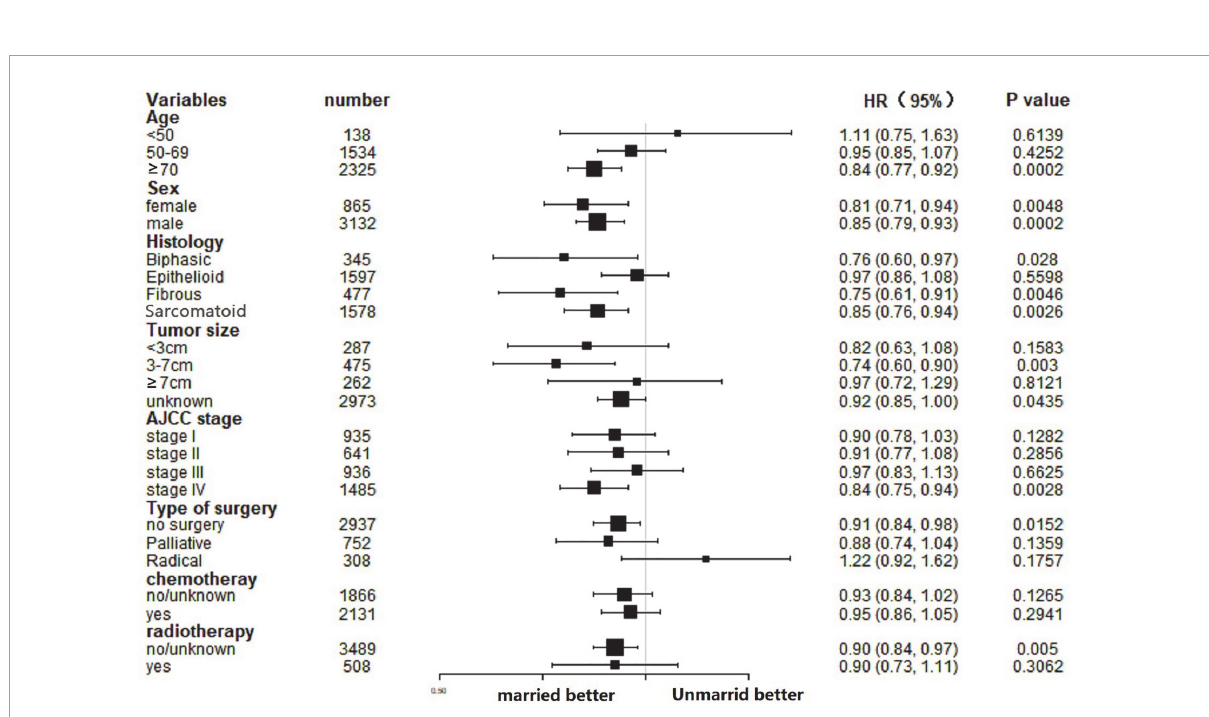
FIGURE4 Forest plot of subgroup analysis for